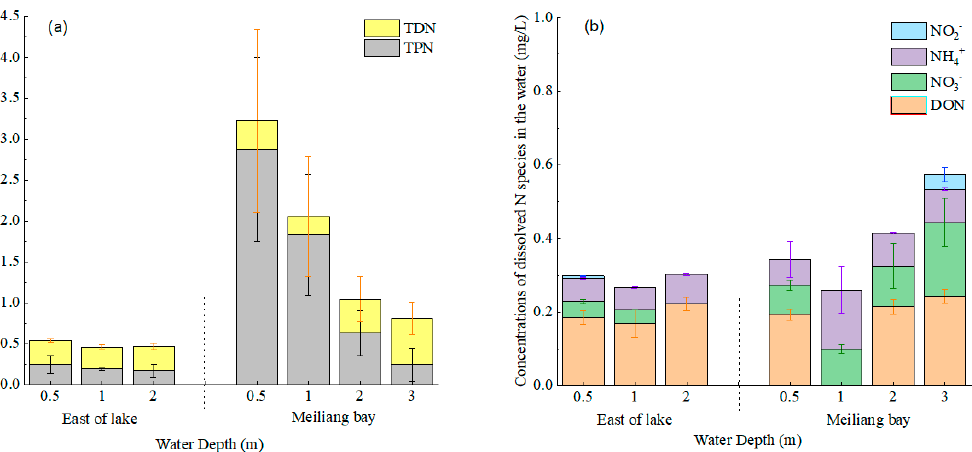
Figure 4. N species in the water layers of Taihu Lake. ( a ) shows TPN and TDN species; ( b ) shows Dissolved N species.